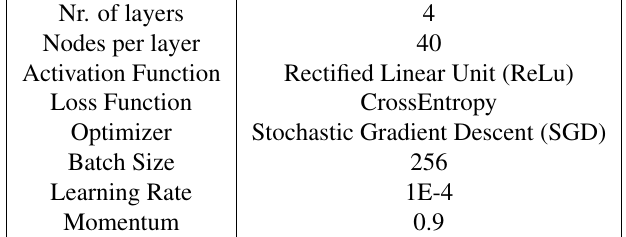
Table 1: Architecture of Feed Forward Neural Networks used to classify HIPs and back- ground clusters.